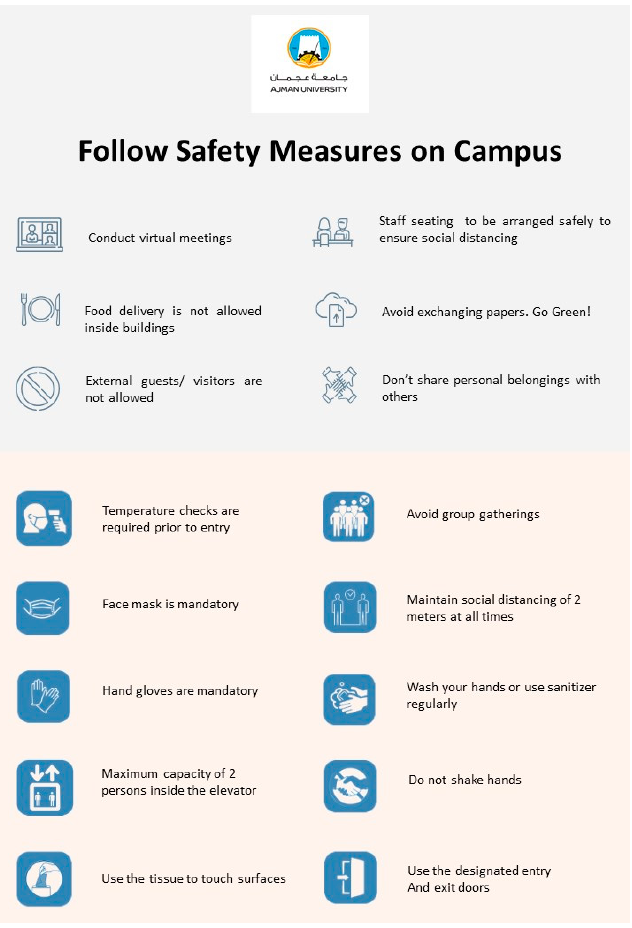
Figure 9. Safety recommendations and measurements during the COVID-19 pandemic implemented by Ajman University (AU), Ajman, UAE. (Reproduced with agreement of the AU Department of Environmental Health and Safety (EHS) on 11 May 2020.).